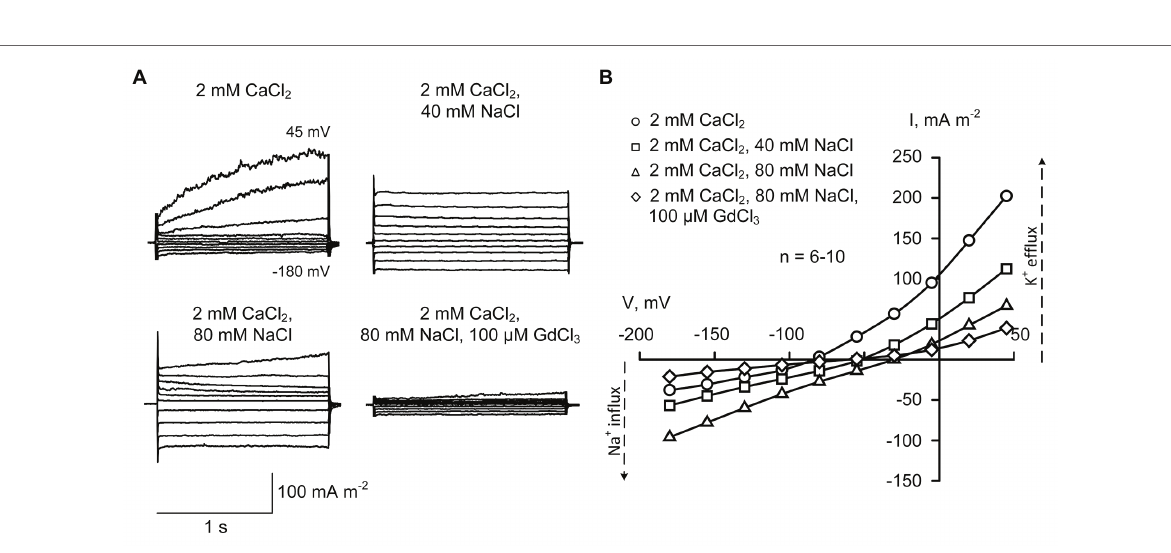
FIGURE 3 | Typical plasma membrane currents (A) and mean current-voltage curves (B) in H. annuus L. root protoplasts recorded in the presence of 2 mM CaCl 2 in the bathing solution at different levels of external NaCl (40 and 80 mM). Current-voltage curves were plotted by mean values ( n = 6–10; errors are not shown in the figure). Statistically significant ( p < 0.01; ANOVA test) difference between “2 mM CaCl 2 ” (circles) and “40 mM NaCl” (squares) was found at all voltage values apart from − 105 mV. The difference between “2 mM CaCl 2 ” (circles) and “80 mM NaCl” (triangles) was statistically significant at all voltage values ( p < 0.01; ANOVA test). The standard bathing solution contained (in mM): 0.3 KCl, 2 Tris, adjusted to pH 6.0 with 1 MES, and 600 mOsM, with D-sorbitol. The pipette solution contained 70 mM K gluconate, 10 mM KCl; 100 nM Ca 2+ was adjusted with 1 mM BAPTA and 0.475 mM CaCl 2 , pH 7.2 with 2 mM Tris, 1 mM MES. 100 μ M GdCl 3 was added to the bathing solution on the background of 2 mM CaCl 2 and 80 mM NaCl for 5 min before recording current-voltage curves.